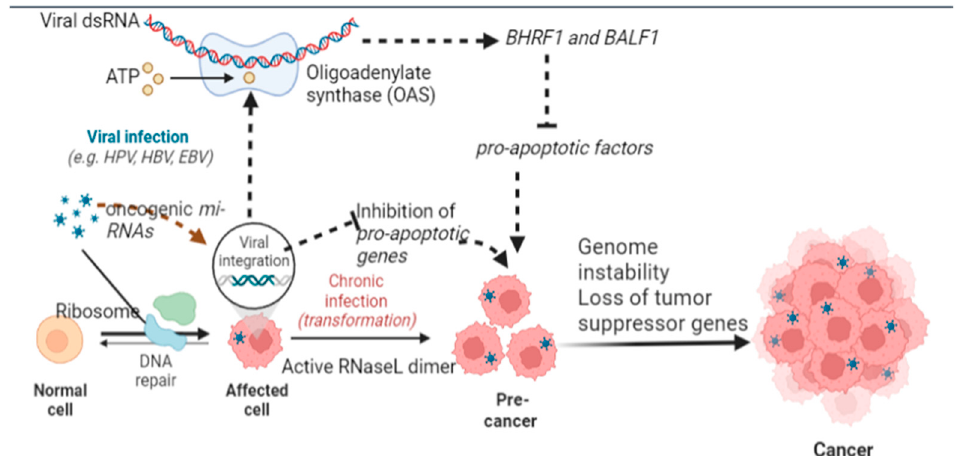
Figure 2. Mechanistic alteration in cellular and subcellular architecture of host cell caused by oncogenic viruses which inhibit programmed cell death and cause transition of a normal cell to cancerous cell (Image created by biorender.com, accessed on 2 November 2022).